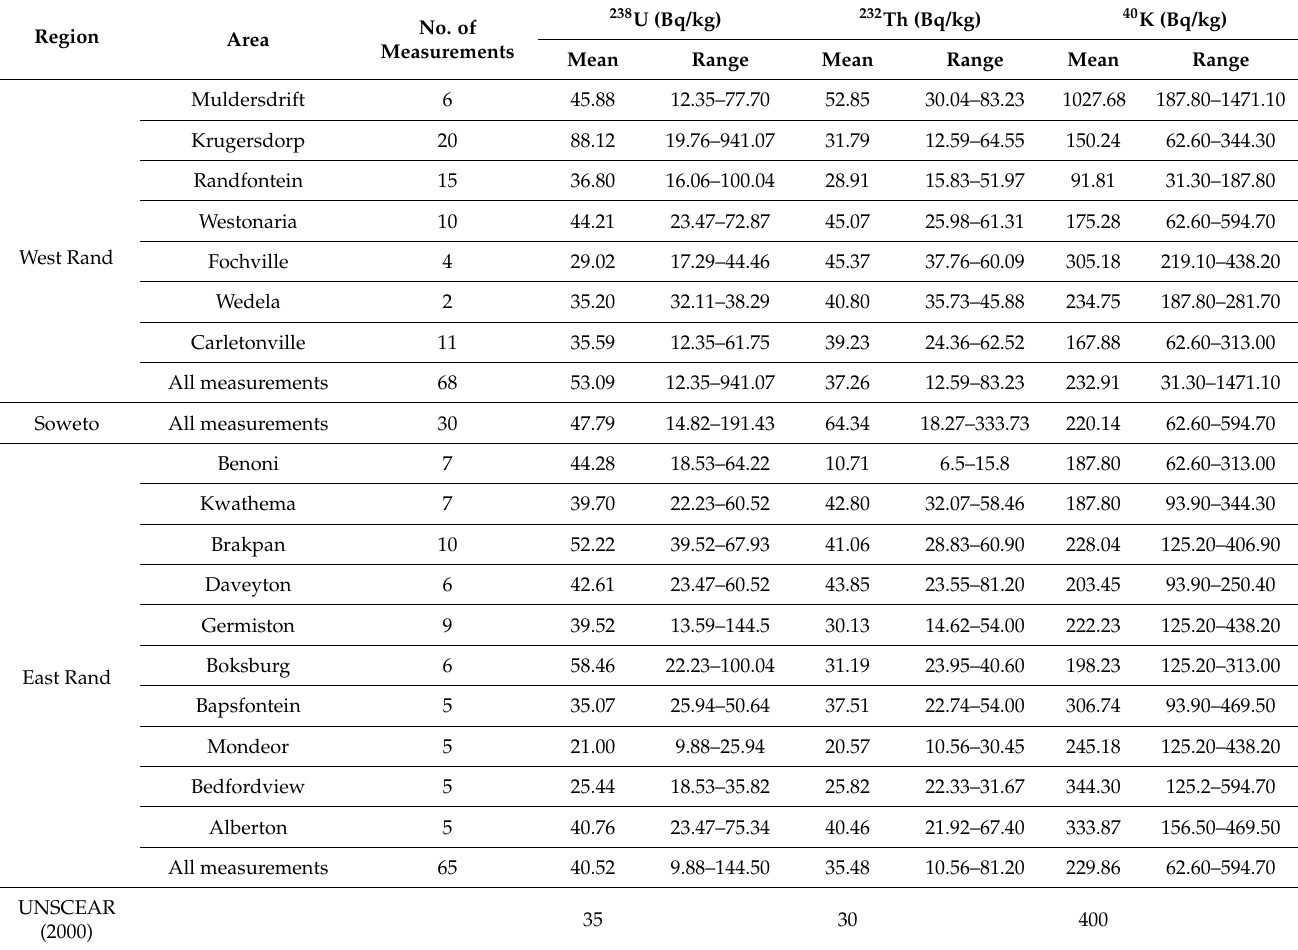
Table 3. In situ activity concentration of the 238 U, 232 Th, and 40 K in the soils of the West Rand, East Rand, and